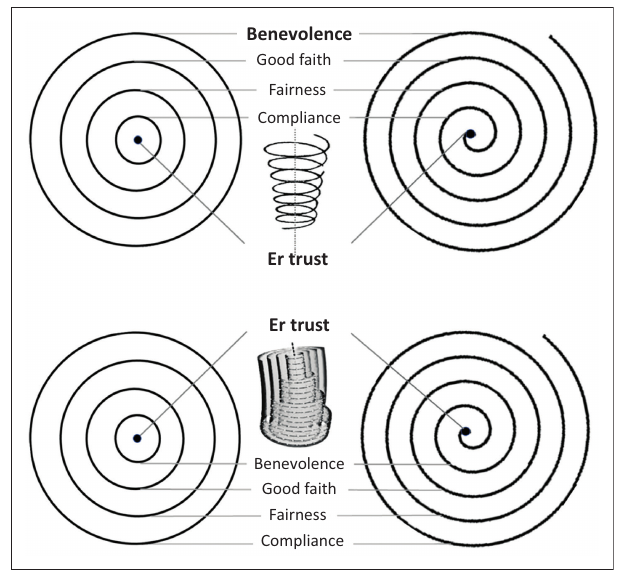
FIGURE 4: Employment relations trust development in vortex and spiral